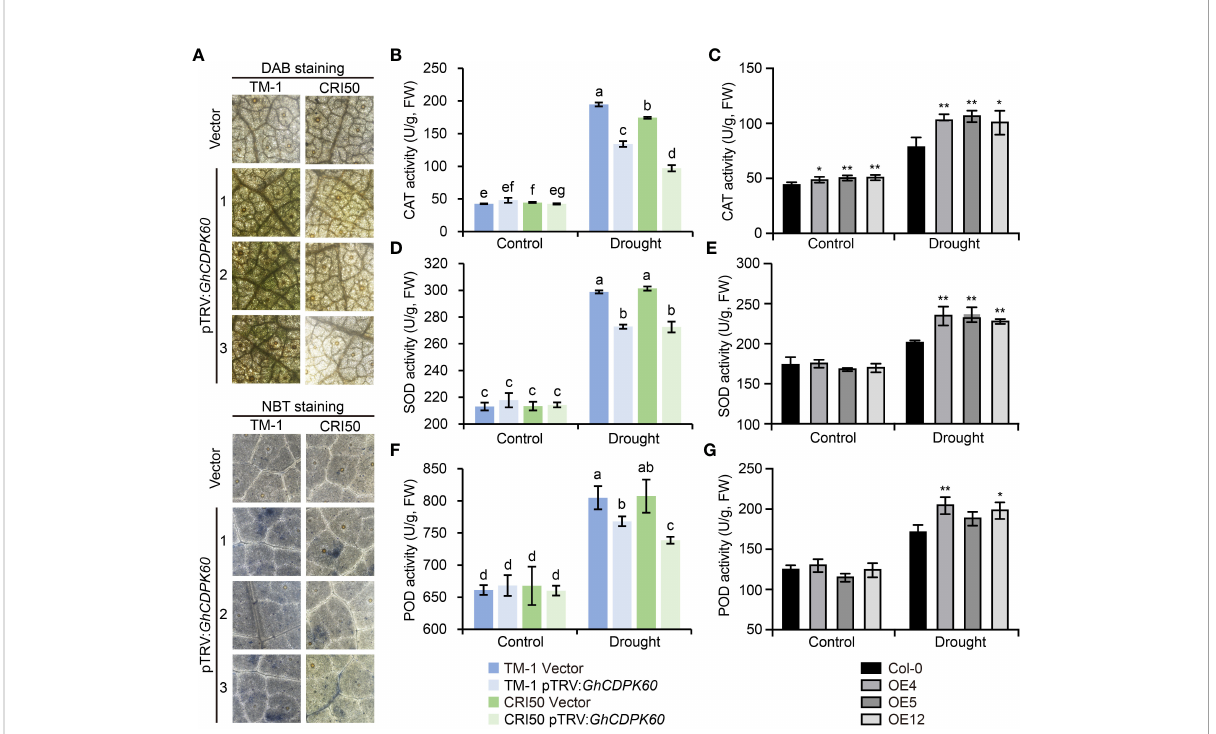
FIGURE 6 Visualization of ROS and determination of antioxidant enzyme activities. (A) H 2 O 2 and O − 2 visualization in cotton leaves by staining with DAB and NBT, respectively. (B-G) Measurements of CAT (B, C) , SOD (D, E) , and POD (F, G) activities in cotton and Arabidopsis leaves after drought treatment, respectively. Statistically signi fi cant differences compared to Col-0. Values represent the mean ± SE from three biological replicates. * P < 0.05 and ** P < 0.01 by Student ’ s t test. Columns with different letters indicate signi fi cant differences ( P < 0.05, Student ’ s t